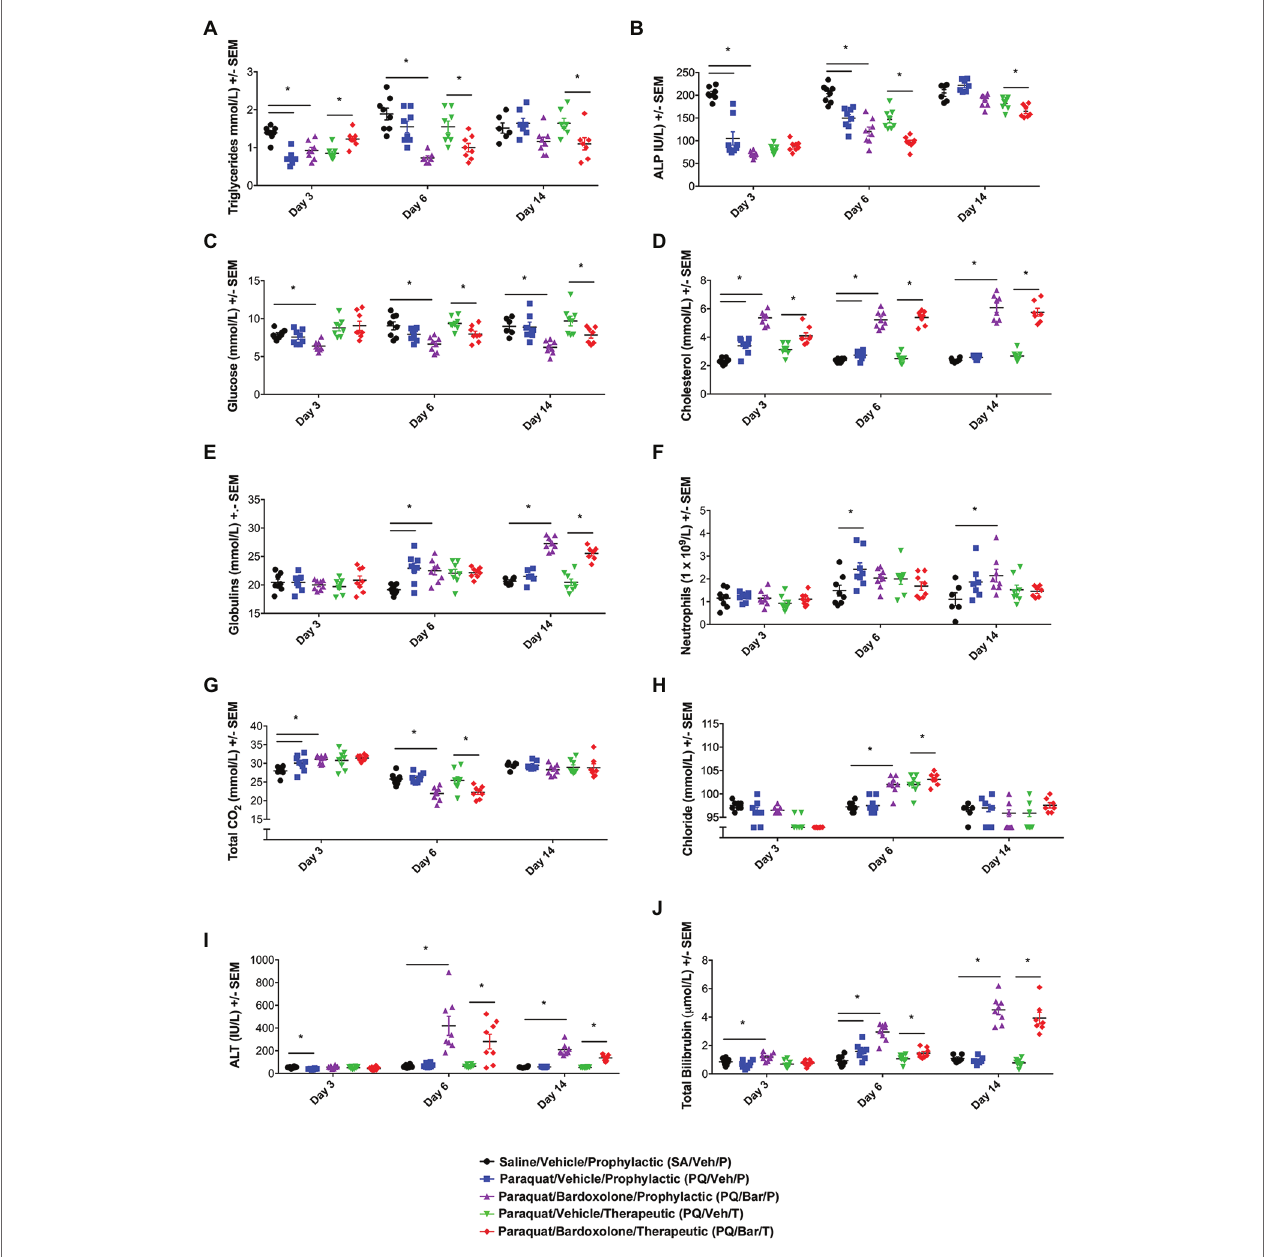
FIGURE 3 | Clinical pathology performed at distinct time points showed changes in response to PQ administration and bardoxolone treatment. (A) Triglycerides. PQ/Veh/P rats showed lower triglyceride levels on Day 3 compared with SA/Veh/P. Bardoxolone-treated rats (PQ/Bar/P and PQ/Bar/T) demonstrated changes as early as Day 3 and as late as Day 14. (B) Alkaline Phosphatase (ALP). PQ/Veh/P rats showed lower ALP levels on Days 3 and 6 compared with SA/Veh/P. PQ/Bar/P and PQ/Bar/T rats demonstrated lower levels as early as Day 3 and as late as Day 14. (C) Glucose. SA/Veh/P and PQ/Veh/P rats showed similar glucose levels at all evaluated time points. In contrast, PQ/Bar/P and PQ/Bar/T rats demonstrated lower levels as early as Day 3 and as late as Day 14. (D) Cholesterol. PQ/Veh/P rats showed higher cholesterol levels on Days 3 and 6 compared with SA/Veh/P. PQ/Bar/P and PQ/Bar/T rats demonstrated higher levels at all evaluated time points. (E) Globulins. PQ/Veh/P rats showed higher globulin levels on Day 6 compared with SA/Veh/P. PQ/Bar/P and PQ/Bar/T rats demonstrated higher levels as early as Day 6 and as late as Day 14. (F) Neutrophils. PQ/Veh/P rats showed higher neutrophil levels on Day 6 compared with SA/Veh/P. PQ/Bar/P rats demonstrated higher levels on Day 14. (G) Total CO 2 or bicarbonate. PQ/Veh/P rats showed higher total CO 2 levels on Day 3 compared with SA/Veh/P. PQ/Bar/P rats demonstrated higher levels on Day 3 and lower levels on Day 6. PQ/Bar/T rats demonstrated lower levels on Day 6. (H) Chloride. SA/Veh/P and PQ/Veh/P rats showed similar chloride levels at all evaluated time points. PQ/Bar/P and PQ/Bar/T rats demonstrated higher levels on Day 6. (I) Alanine transaminase (ALT). PQ/Veh/P rats showed lower ALT levels on Day 3 compared with SA/Veh/P. PQ/Bar/P and PQ/Bar/T rats demonstrated higher levels on Days 6 and 14. (J) Total Bilirubin. PQ/Veh/P rats showed higher total bilirubin levels on Day 6 compared with SA/Veh/P. PQ/Bar/P and PQ/Bar/T rats demonstrated higher levels as early as Day 3 and as late as Day 6. * p ≤ 0.05 vs. SA/Veh/P or PQ/Veh/T. Error bars are +/ − SEM. n = 6–8 rats per study group per time